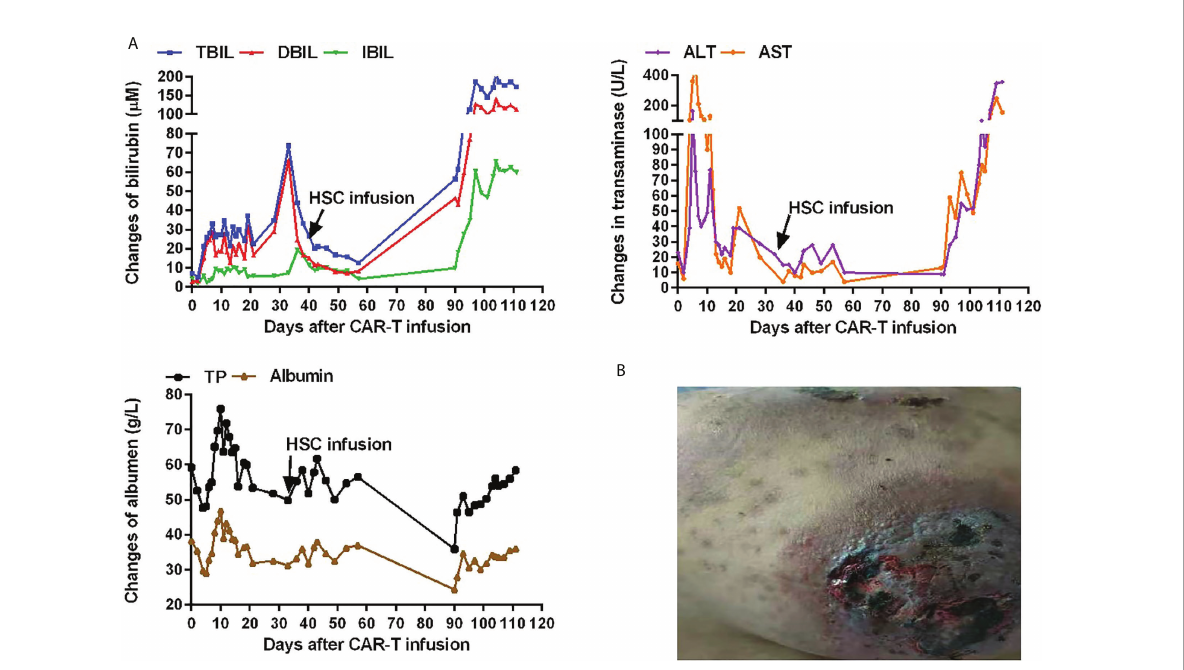
FIGURE 2 Hepatic function and skin changes after CAR-T cell infusion. (A) Hepatic function after CAR-T cell infusion. Expression of total bilirubin (TBIL; normal range, 0 – 21 µM), direct bilirubin (DBIL; normal range, 0 – 5 µM), indirect bilirubin (IBIL; normal range, 0 – 15 µM), alanine transaminase (ALT; normal range, 5 – 40 U/L), aspartate transaminase (AST; normal range, 8 – 40 U/L), total protein (TP; normal range, 64 – 83 g/L), and albumin (normal range, 34 – 48 g/L) after CAR-T cell infusion. (B) Skin pigmentation and a festering skin rash after CAR-T cell